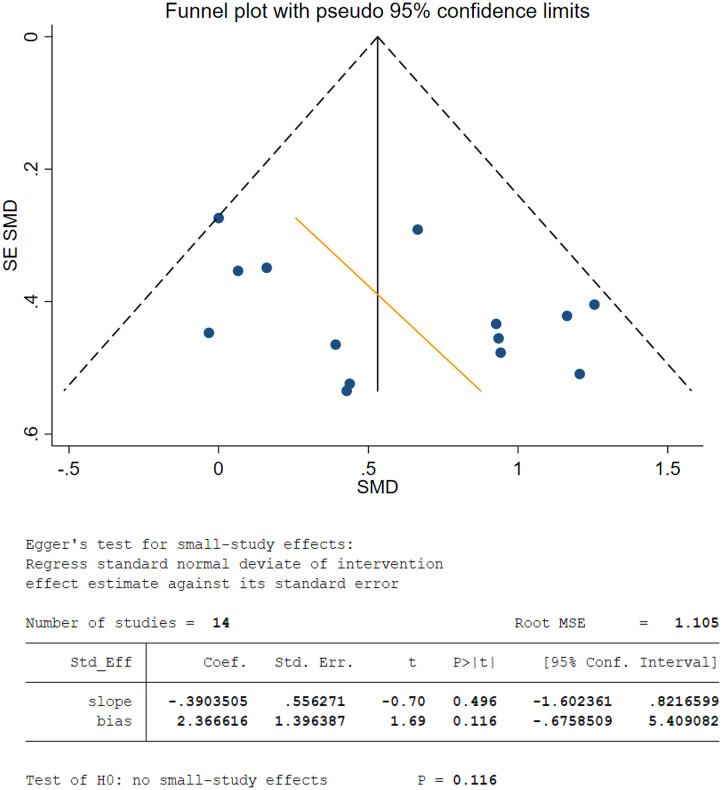
Funnel plot and Egger's test for meta-analysis of effects of alpha neurofeedback training (NFT) on working memory. Each point represents an independent study for the indicated associate. Coef, coefficient; MSE, mean standard error; SE, standard error; SMD, standardized mean difference; Std_eff, standard effects.